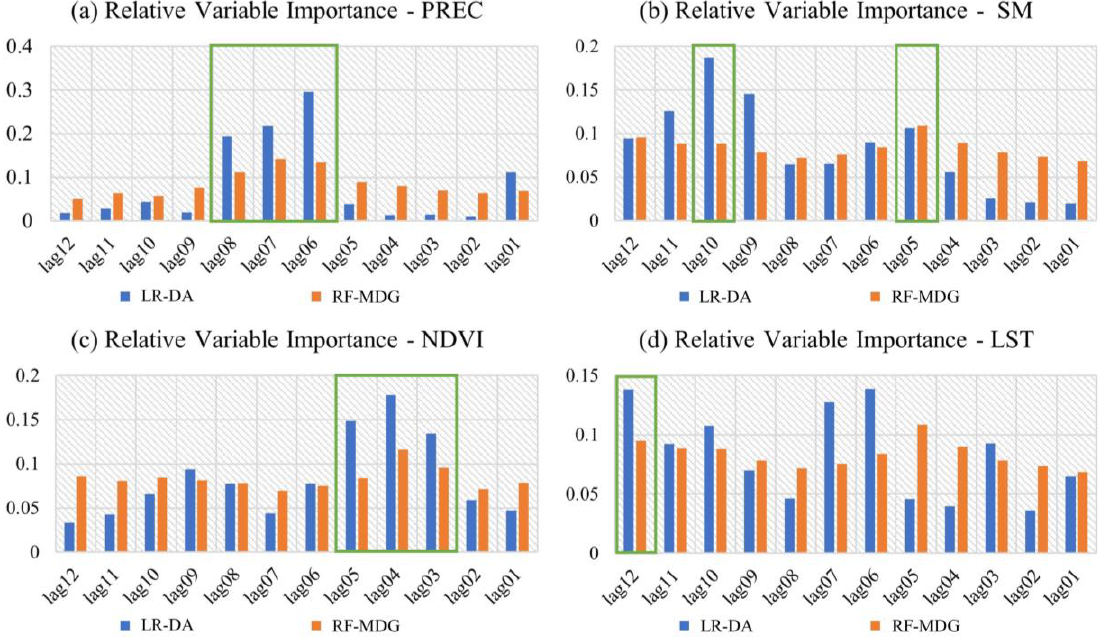
Figure 6. The normalized relative importance of time-lagged variables of each dynamic indicator. The green box refers to the optimal temporal sliding window. ( a ) Relative variable importance of PREC. ( b ) Relative variable importance of SM. ( c ) Relative variable importance of NDVI. ( d ) Relative variable importance of LST. The blue bar represents the relative variable importance of LR-DA while the orange box refers to that of RF-MDG.